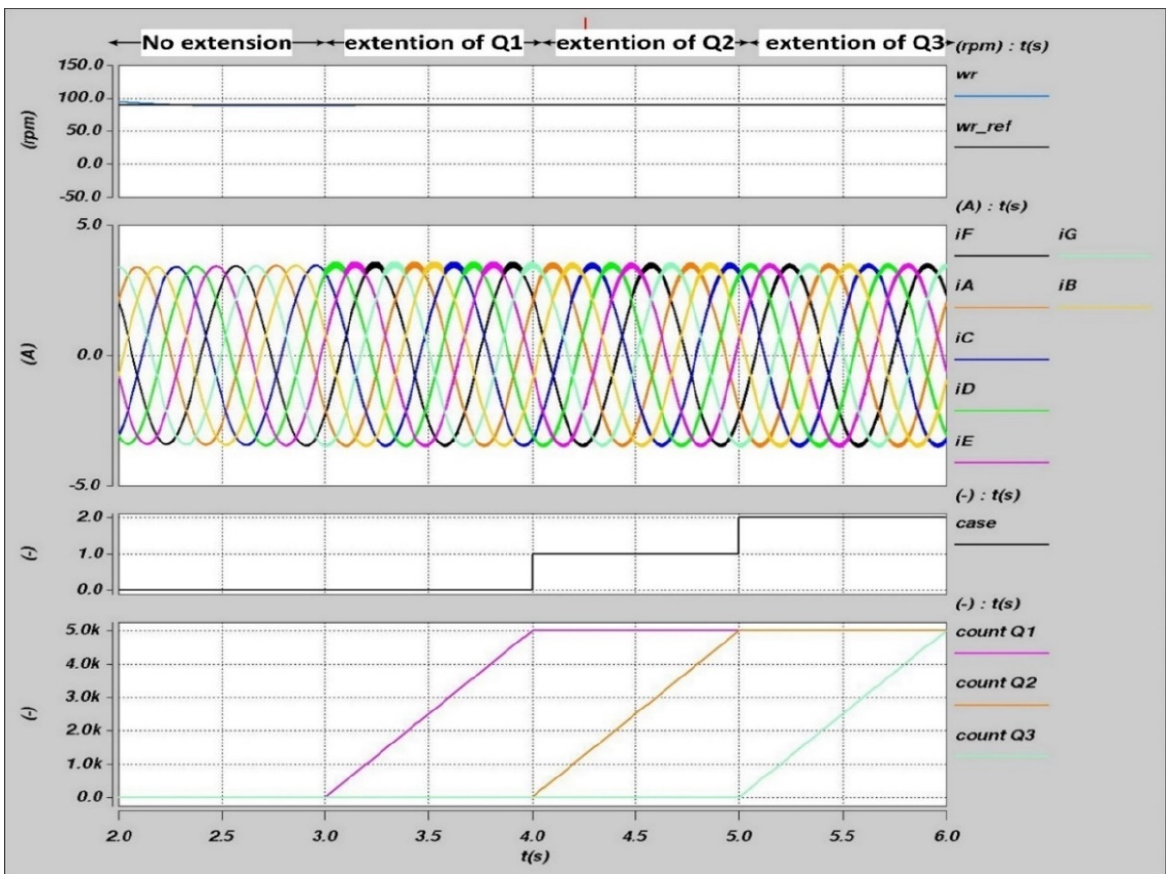
Figure 17. Current waveforms at 90 rpm using different extension schemes.